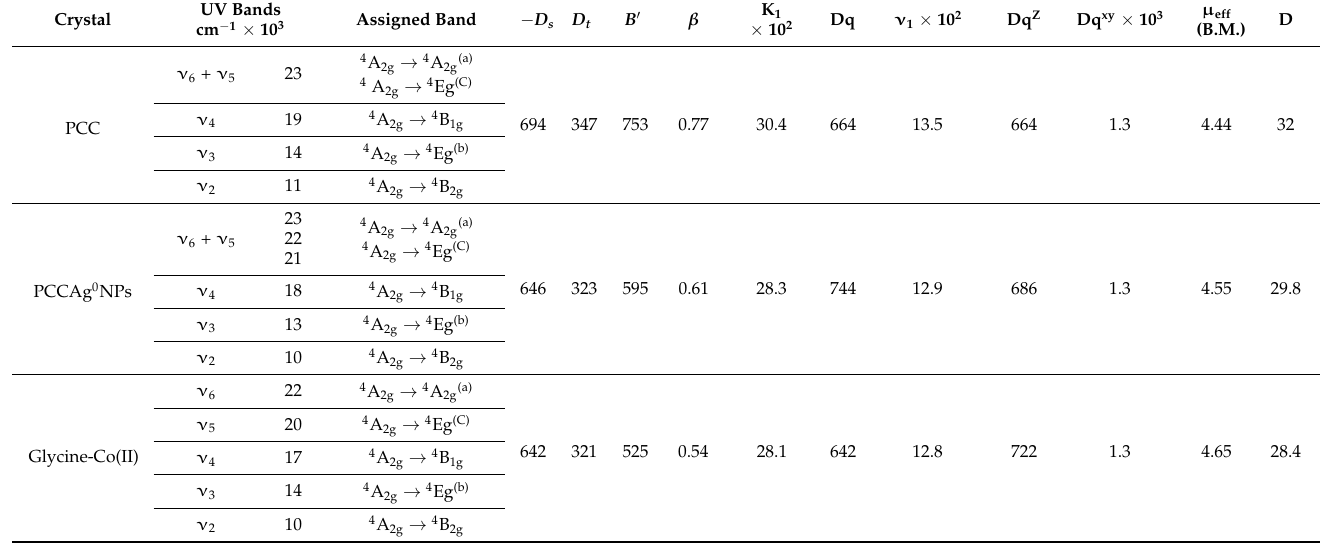
N.B. (parameters D s , D t , B (cid:48) , K 1 , Dq, ν are cm − 1